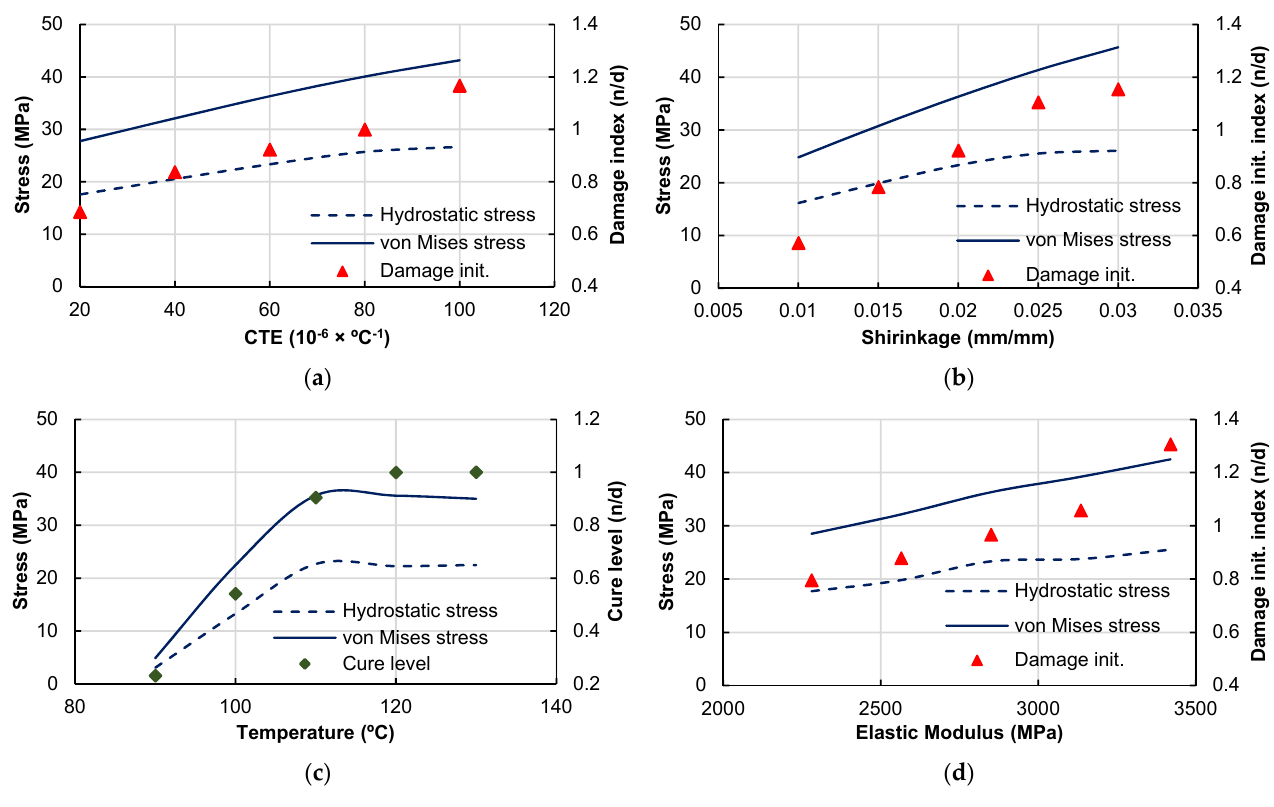
Figure 16. Micro-residual stresses and failure index/cure level sensitivity to material and process parameters. ( a ) Thermal expansion sensitivity results, ( b ) Chemical shrinkage sensitivity results, ( c ) Cure temperature sensitivity results, ( d ) Matrix elastic modulus sensitivity results.